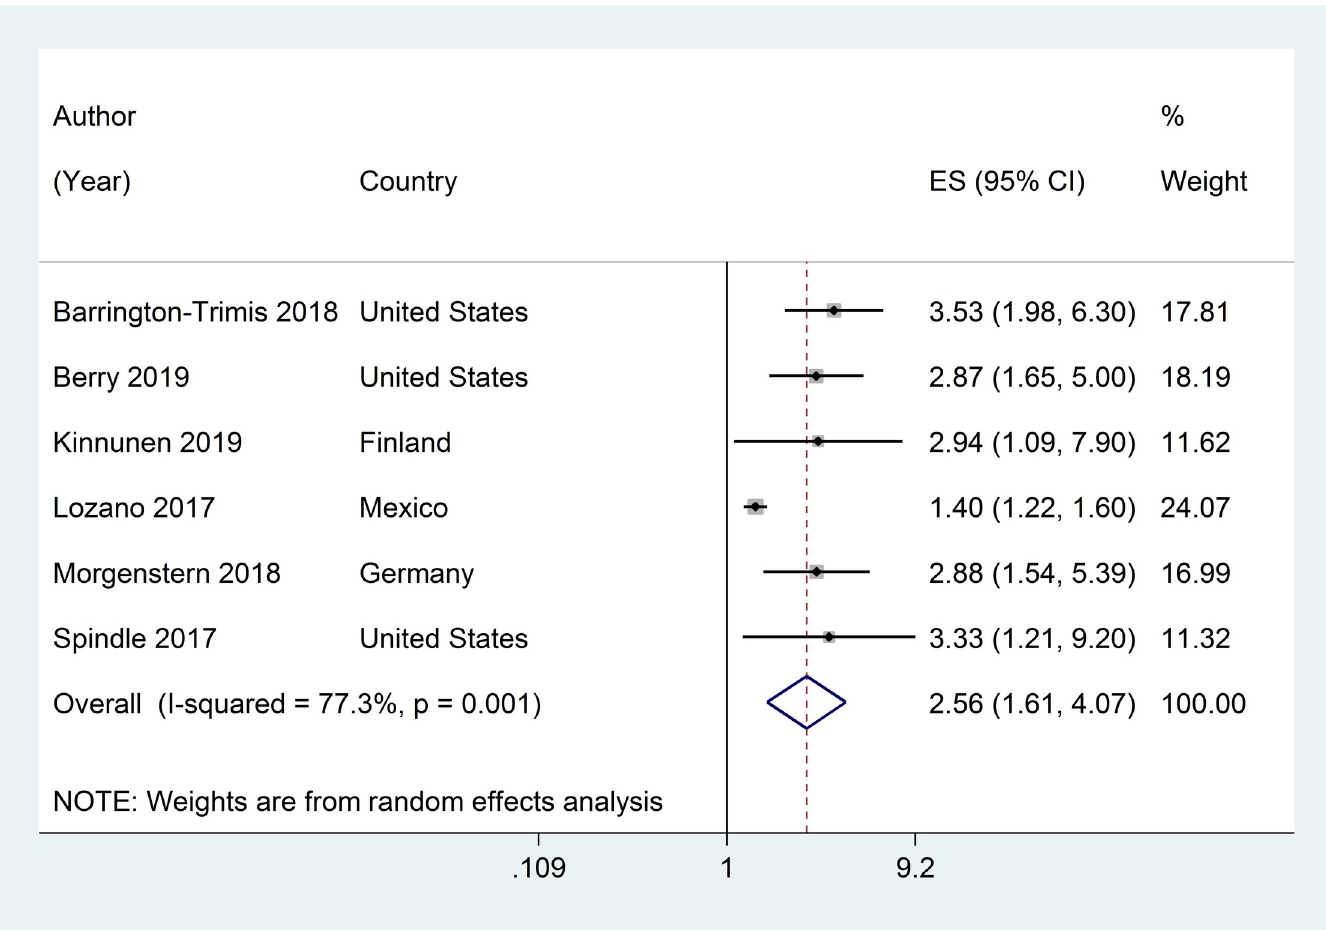
Fig 4. Forest plot of adjusted risk ratios assessing the association between ever e-cigarette use at baseline and subsequent current cigarette use at follow-up.